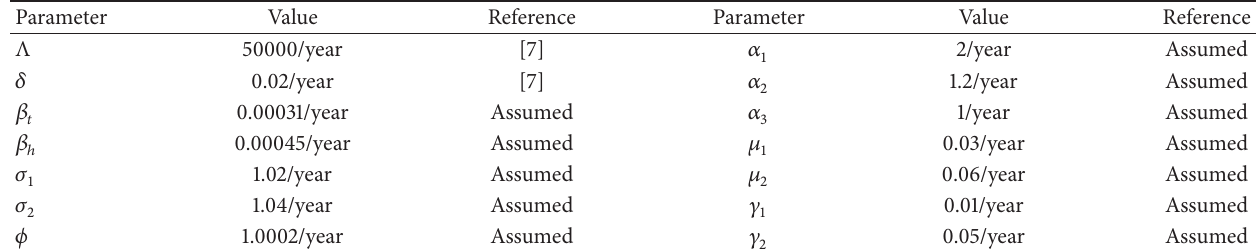
Table 1: Parameter values.